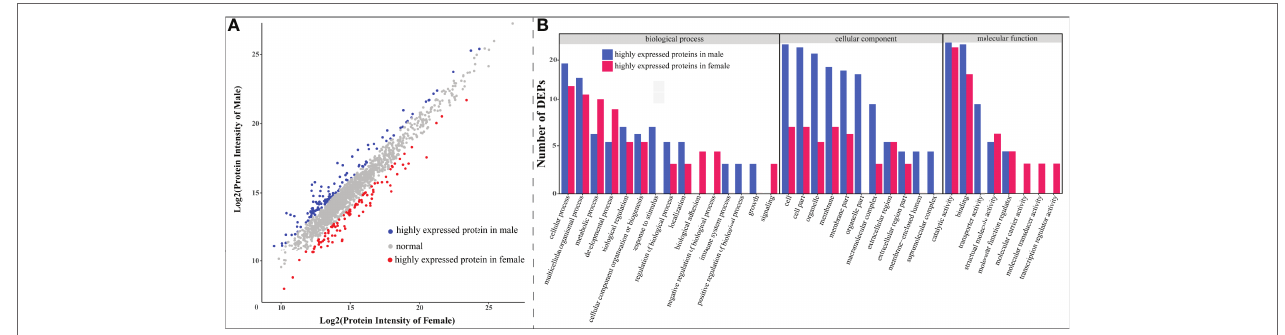
FIGURE 6 | Statistics of differentially expressed proteins (DEPs) between female and male seahorses. (A) A scatter plot of all quantitative proteins. The x-axis and y-axis represent log2(protein intensity) of female and male samples, respectively. The red and blue dots represent DEPs in female and male respectively, while the rest gray dots stand for proteins without sexual difference. (B) Enriched Gene Ontology (GO) functional terms of identified DEPs. The x-axis represents GO term, and the y-axis denotes the number of each DEP. The red and blue bars stand for female and male upregulated proteins, representatively (as shown in A